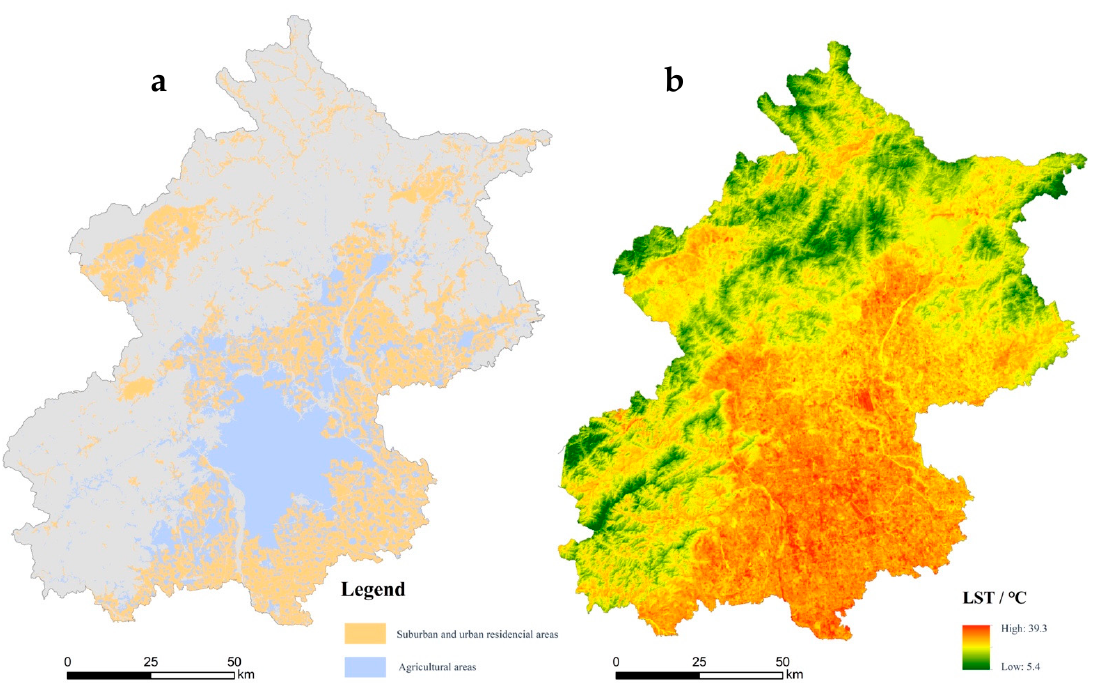
Figure 3. Agricultural fields and residence area identification ( a ); and land surface temperature (LST) map ( b ).